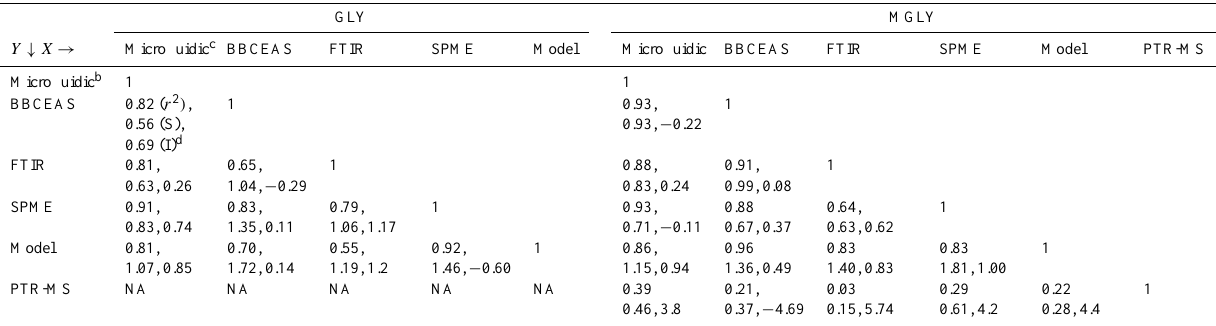
Table 4. Correlation coefficients ( r 2 ) , slopes (S) and intercepts (I) of the linear equations among the microfluidic derivatisation technique and other techniques in the measurement of α -dicarbonyls during isoprene photooxidation in EUPHORE chamber based on the number ( n ) a of experimental data points. Correlations have been performed by averaging the data from the faster instrument over the acquisition time windows of the slower instrument.